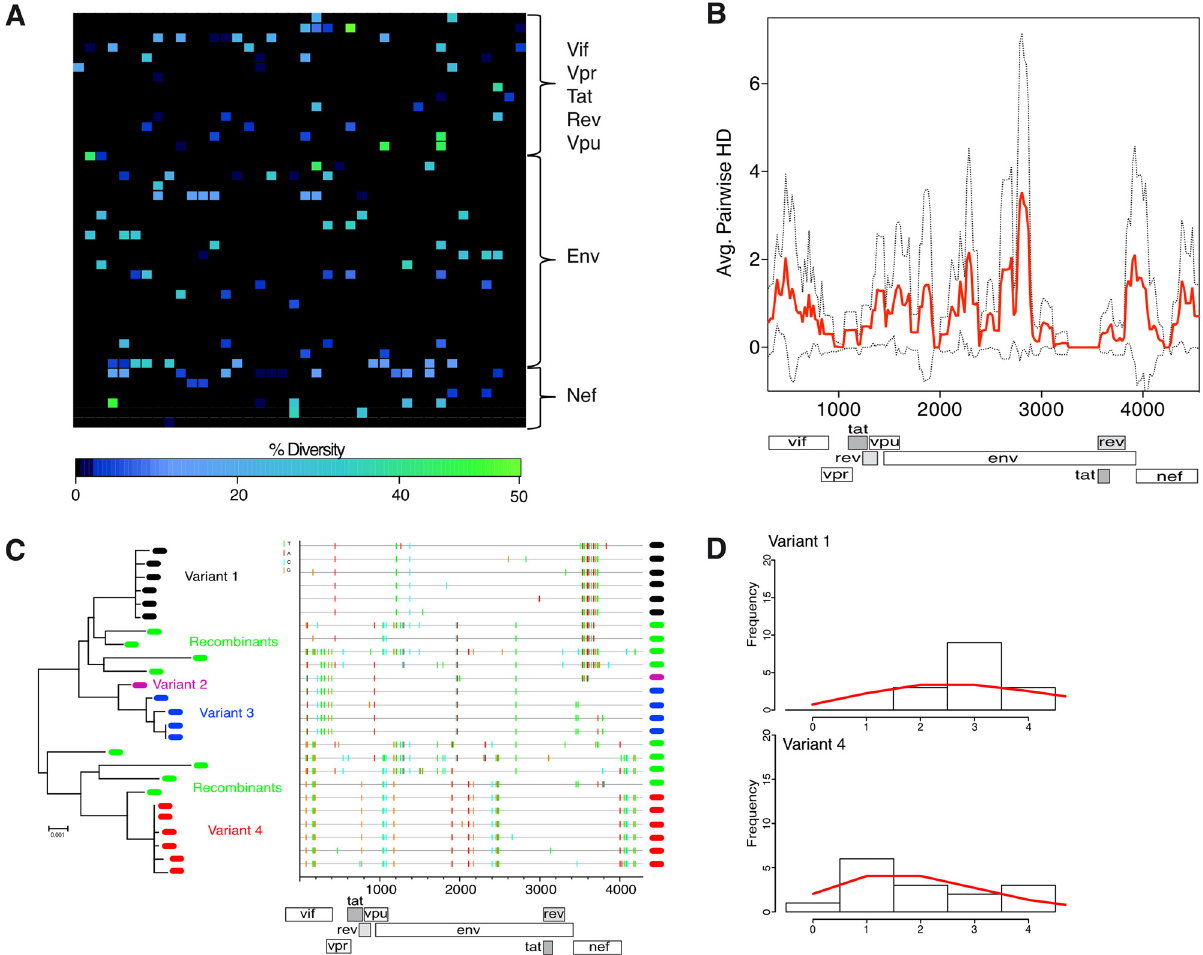
Fig 3. Subject 654207 exhibits high env diversity by both 454 and SGA/S reflective of multiple founder viruses. (A) Heat maps illustrating a number of sites exhibiting amino acid sequence diversity across the 3 0 half of the genome as detected by 454 deep sequencing. Plotted is the percentage of amino acid diversity at each position with the first amino acid of Vif located in the top left corner of the grid and last amino acid of Nef located in the bottom right corner. Completely conserved residues are black and low-level variant residues ( < 10%) are dark blue, moderately variable residues (20%) are sky blue and highly variant residues ( > 40%) are green. (B) The average pairwise hamming distance calculated from 454 sequencing reads for the 3 0 half of the genome is plotted with the APHD of 0.752 (red line) and standard deviation (dotted black line) shown. The plot shows a variable population with a high number of sites exhibiting throughout the genome exhibiting high-level diversity. (C) SGA/Ss from subject 654207 covering the 3 0 half of the HIV-1 genome display a phylogeny (left) revealing productive infection by at least four viruses with inter-lineage recombination. Founder virus lineages are color- coded and labeled variant 1 – 4. Recombinant sequences are shown by green symbols. The highlighter plots (right) compare sequences for each subject ’ s sequence set to an intrasubject consensus (uppermost sequence) and illustrates the pattern of nucleotide base mutations within sequences using short color-coded bars. (D) Hamming distance analysis of SGA/Ss showing infection by multiple viruses with Hamming distance frequencies (mean Hamming distance of 35.38) not conforming to model predictions of a single virus infection. Splitting of variants into their respective sub-lineages such as variants 1 and 4 demonstrate Hamming distance frequencies that do conform to model predictions of a single virus infection (red line). Subject 654207 is viral RNA positive but Western blot negative (stage II/III of